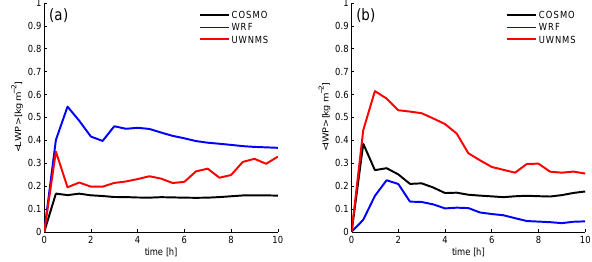
Fig. 6. Time series of liquid water path (LWP) in panel (a) and ice water path (IWP) in panel (b) averaged over the mountain slopes (horizontal distances − 40 to 40km). Note that LWP includes liquid water from cloud droplets and rain and IWP includes ice crystals, snow and graupel.